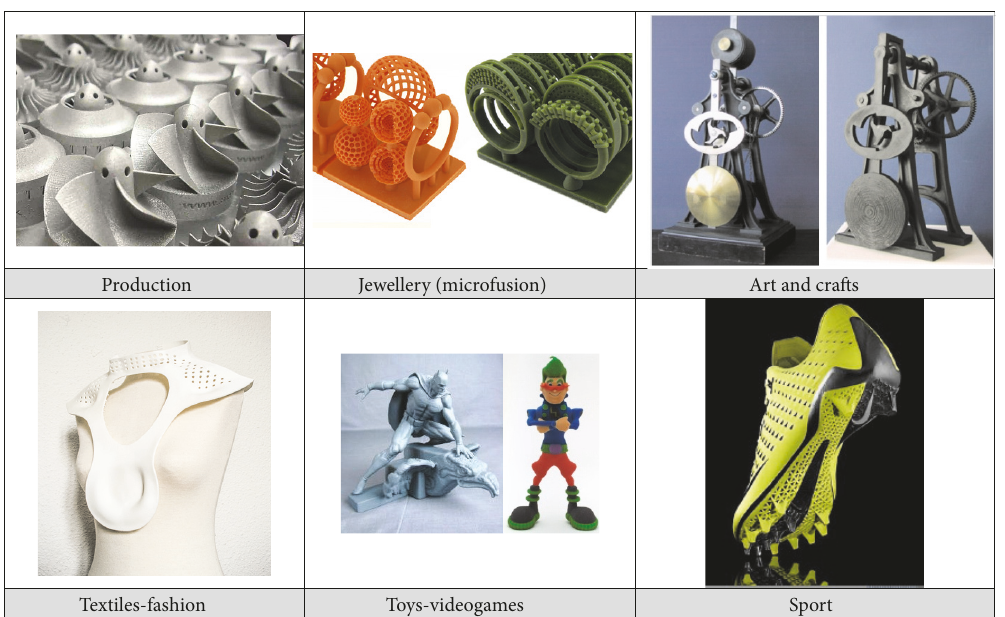
Figure 9: Another AM